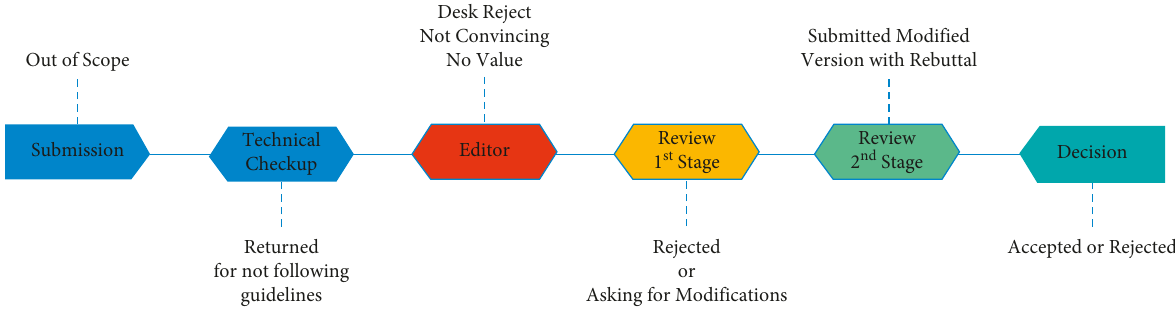
Figure 12: An overview of the journal’s editorial